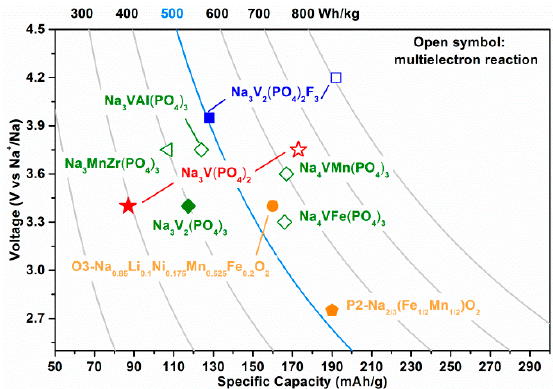
Figure 1. Operation voltages versus specific capacities of cathode materials for sodium-ion batteries.